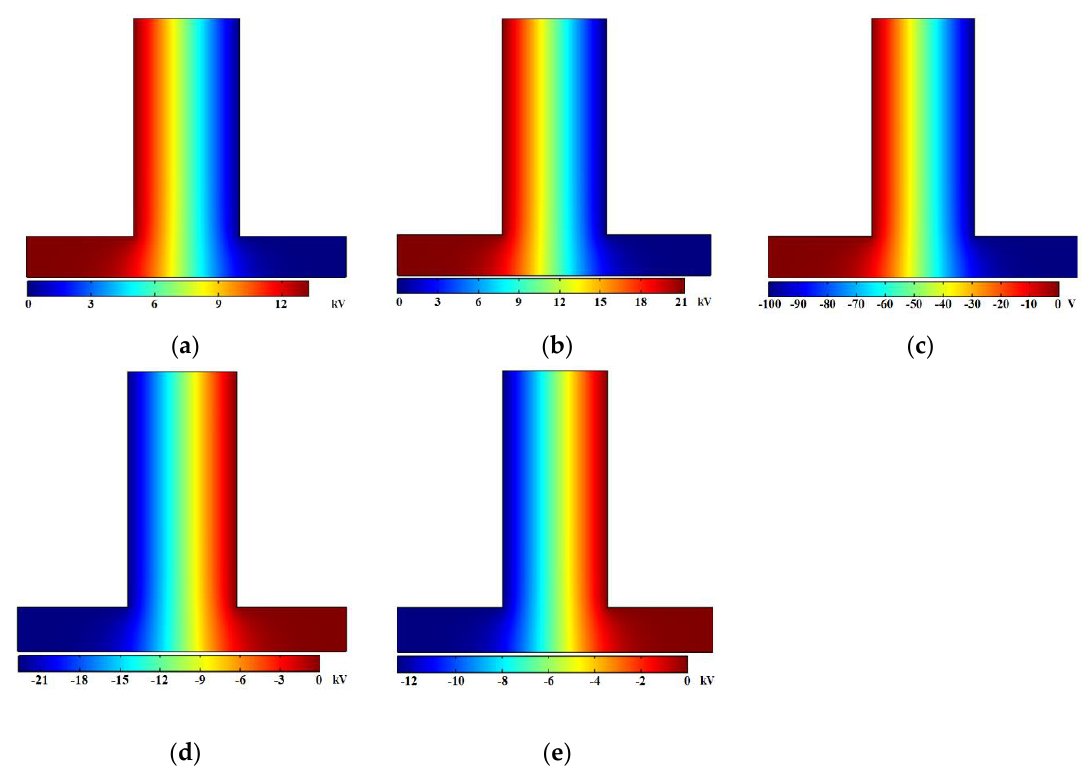
Figure 10. Spatial distribution of the electric potential for times ( a ) 2 ms, ( b ) 6 ms, ( c ) 10 ms, ( d ) 14 ms and ( e ) 18 ms for the reactor at 22 kV AC voltage and 1 cm distance between electrodes.